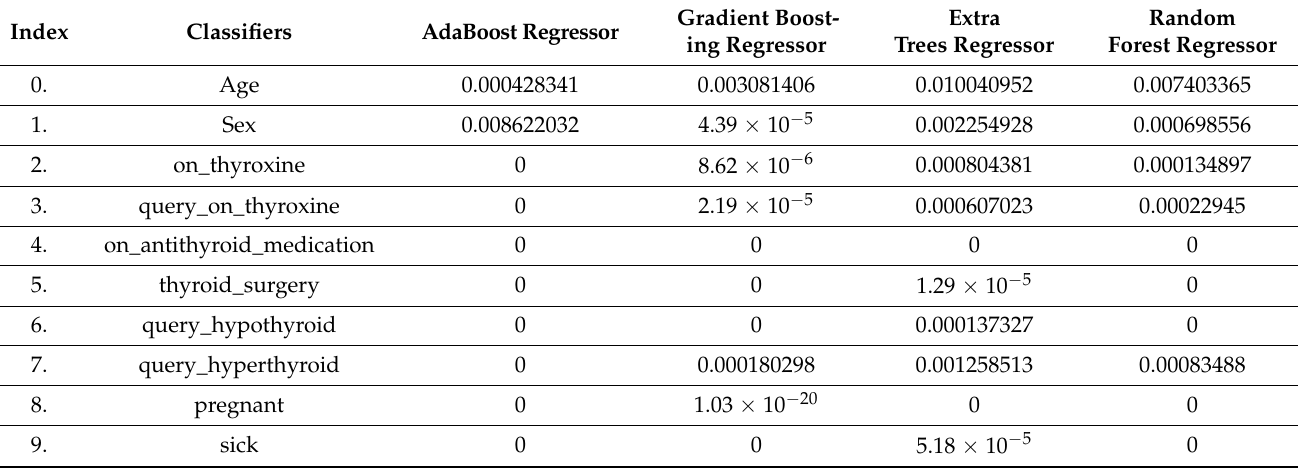
Table 4. Regressor feature importance values of each feature before feature